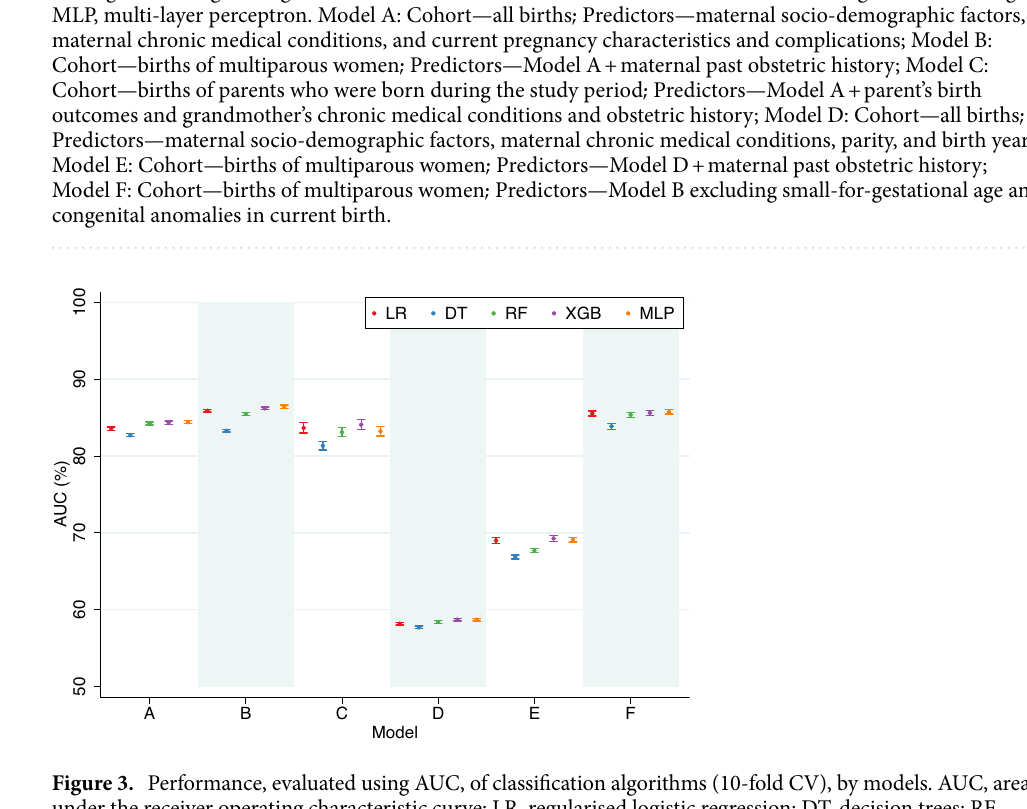
Figure 3. Performance, evaluated using AUC, of classification algorithms (10-fold CV), by models. AUC, area under the receiver operating characteristic curve; LR, regularised logistic regression; DT, decision trees; RF,